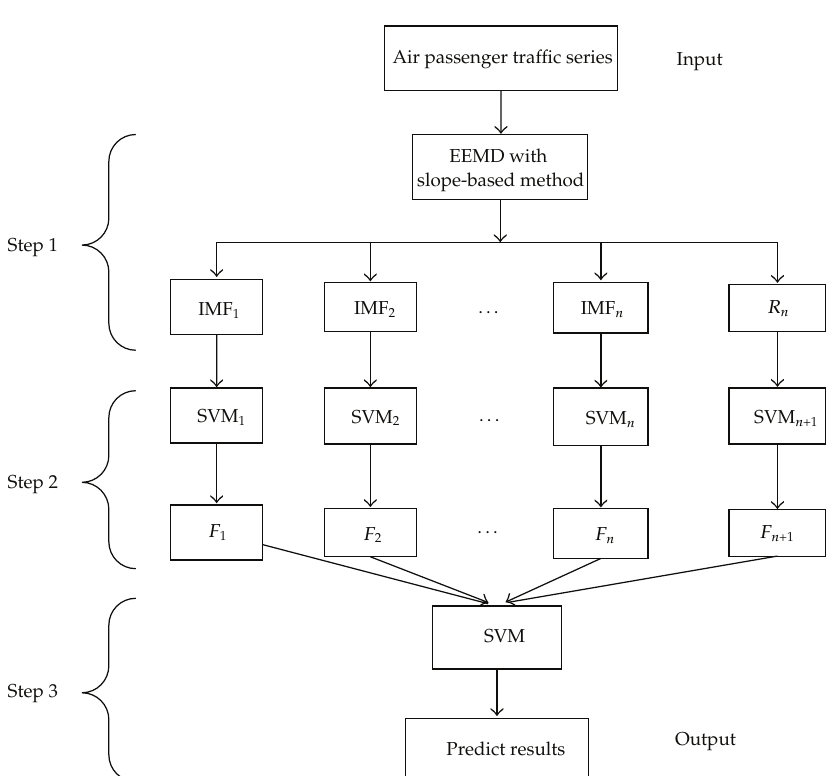
Figure 2: The framework of proposed EEMD-based SVM learning